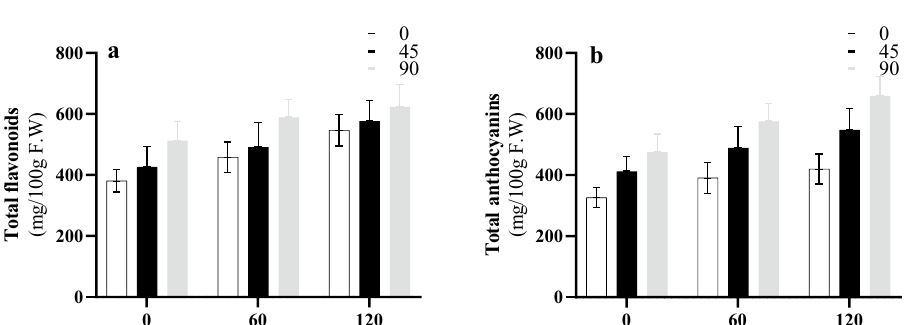
Figure 6. Interactions effects of salinity and NPs on total flavonoids ( a ) and anthocyanin content ( b ) in